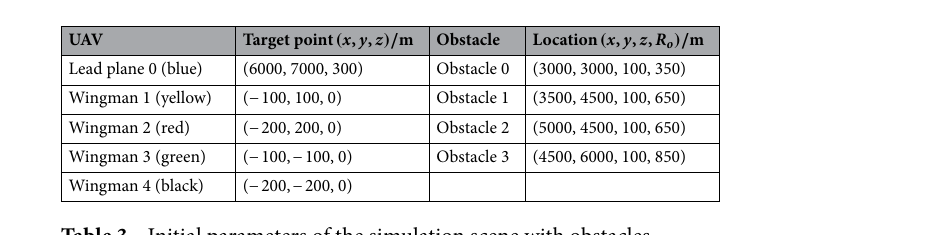
Table 3. Initial parameters of the simulation scene with